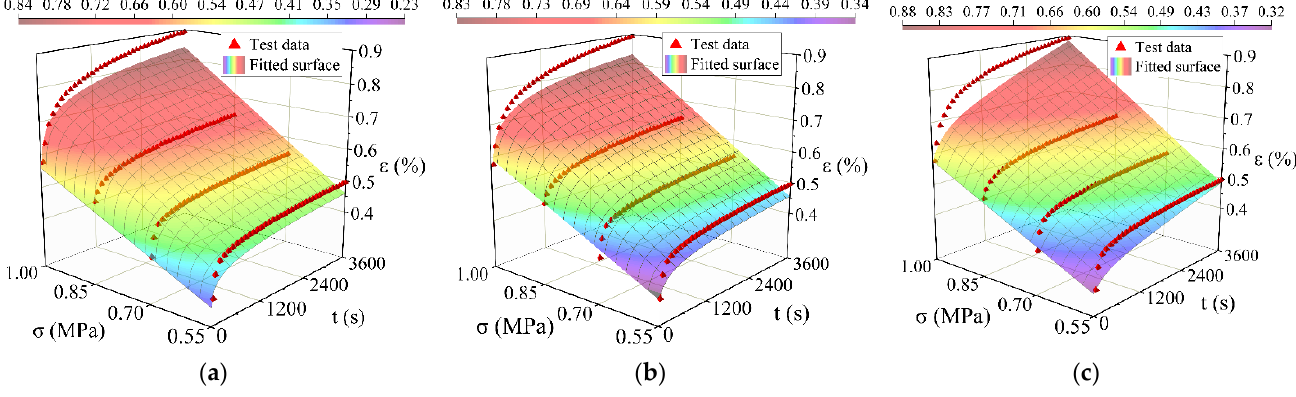
Figure 10. Comparison between test data points with the different model fitted surfaces at 60 °C: ( a ) Fitting result of the time hardening model; ( b ) Fitting result of the modified time hardening model; ( c ) Fitting result of the modified Burgers model. Table 4. Fitting parameters of the time hardening model.